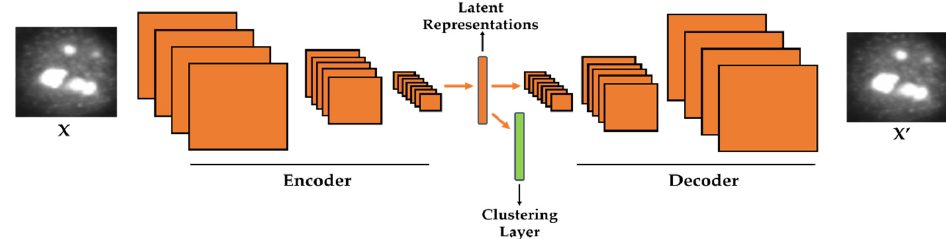
Figure 1. Illustration of the proposed method. A clustering layer is embedded in the convolutional autoencoder in order to learn how to cluster the latent representations. X is the original cellular image and X’ is the